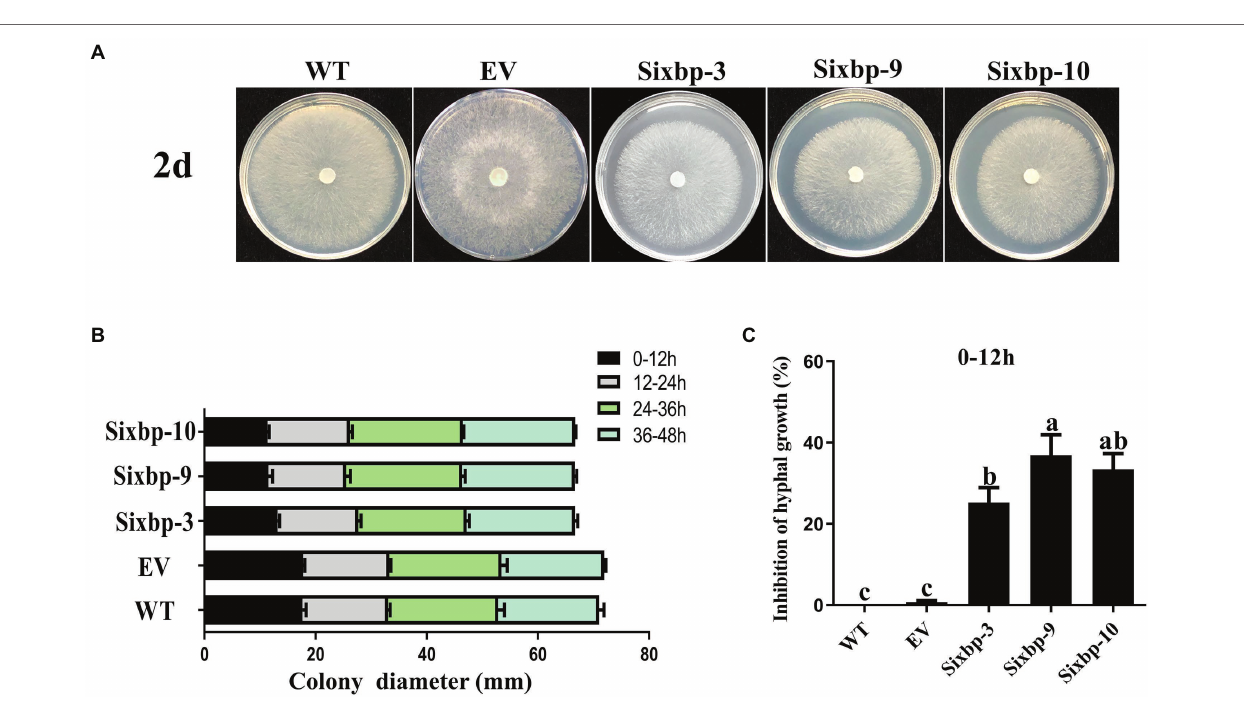
FIGURE 3 | Observations of hyphal growth. (A) The growth of mycelia in wild-type (WT), empty vector (EV), and RNA interference (RNAi) strains. (B) Hyphal growth rates of the RNAi strains and the WT strains cultured on potato dextrose agar (PDA) plates. (C) The inhibition rates of hyphal growth. Different letters above bars represent significant differences ( p < 0.05) as determined using a one-way Duncan’s test. The experiment was repeated three times. Hyphal growth of each strain in different replicates showed similar